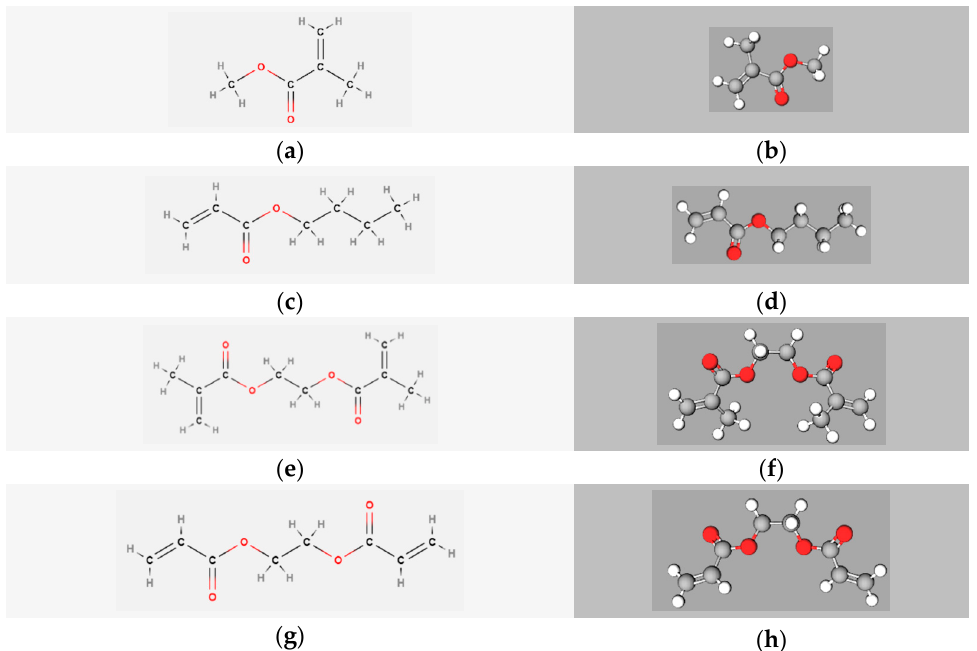
Figure 1. Chemical representations of Methyl Methacrylate ( a , b ), n -Butyl Acrylate ( c , d ), Ethylene Glycol Dimethacrylate ( e , f ), and Ethylene Glycol Diacrylate ( g , h ). The left side corresponds to a structural model of the chemical formula, while the right side corresponds to a 3D model based on spheres and sticks.